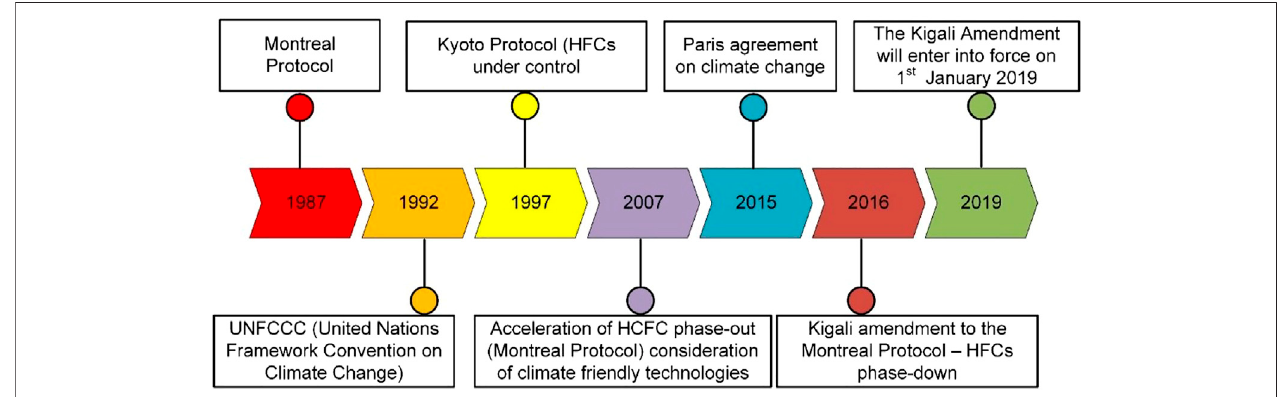
FIGURE 3 | A brief history of the protocols and accords for ozone depletion and climate change.